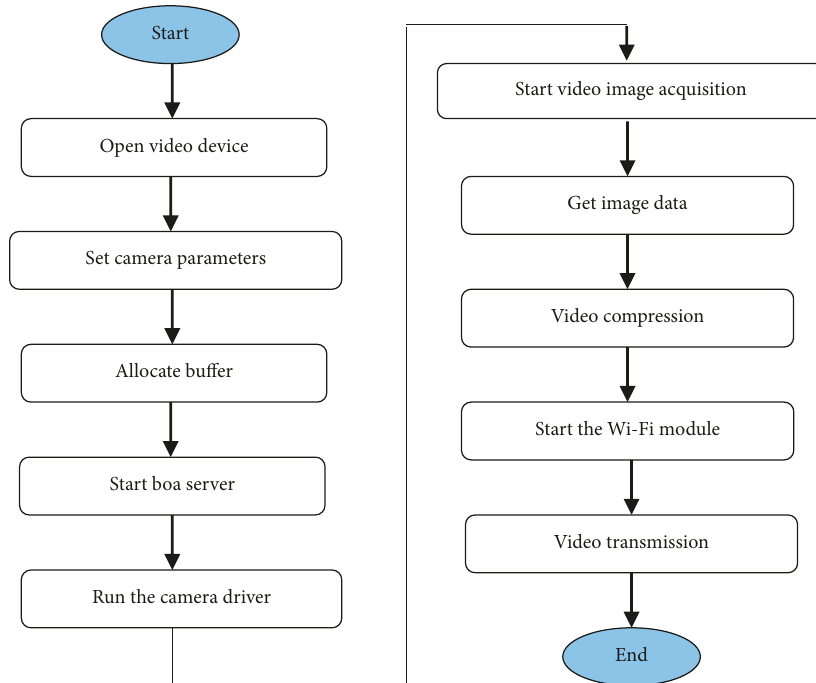
Figure 5: Software design flow chart of the videos and images collection function.